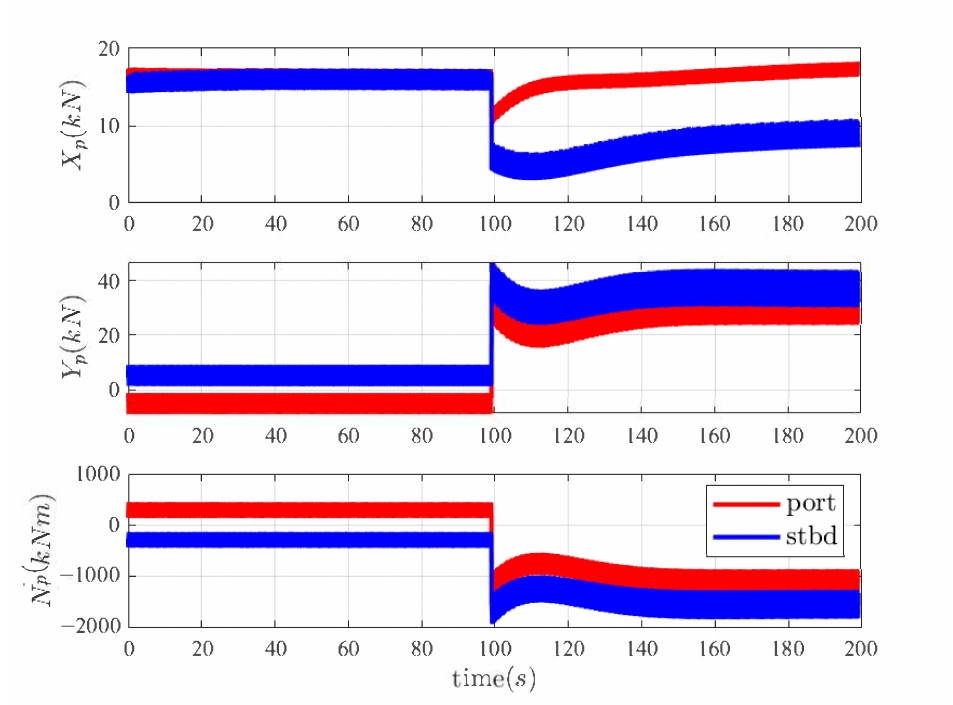
Figure 12. Propeller delivered forces and